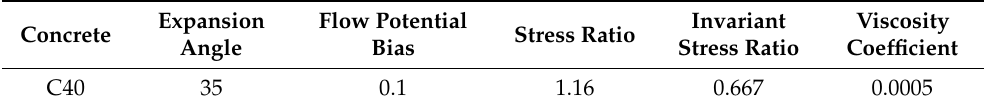
Table 3. Plastic damage parameters for concrete.